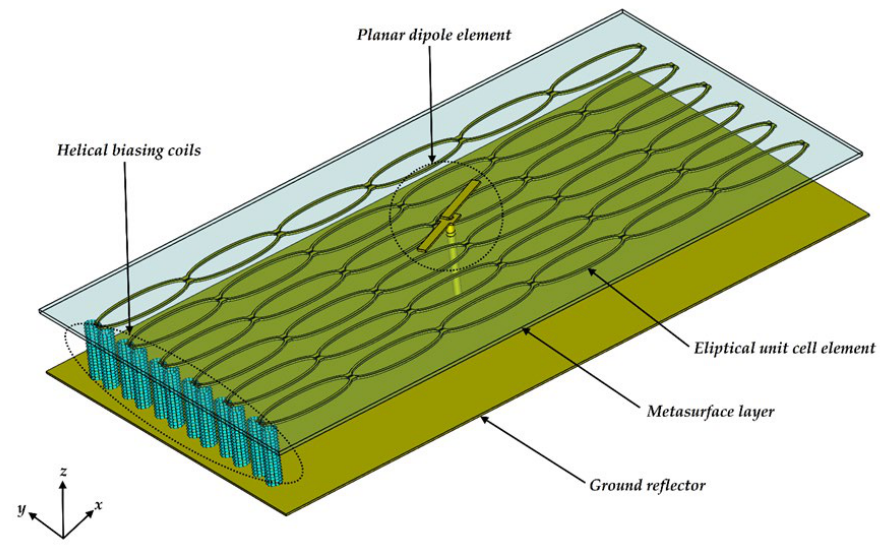
Figure 1. Three-dimensional antenna structure.